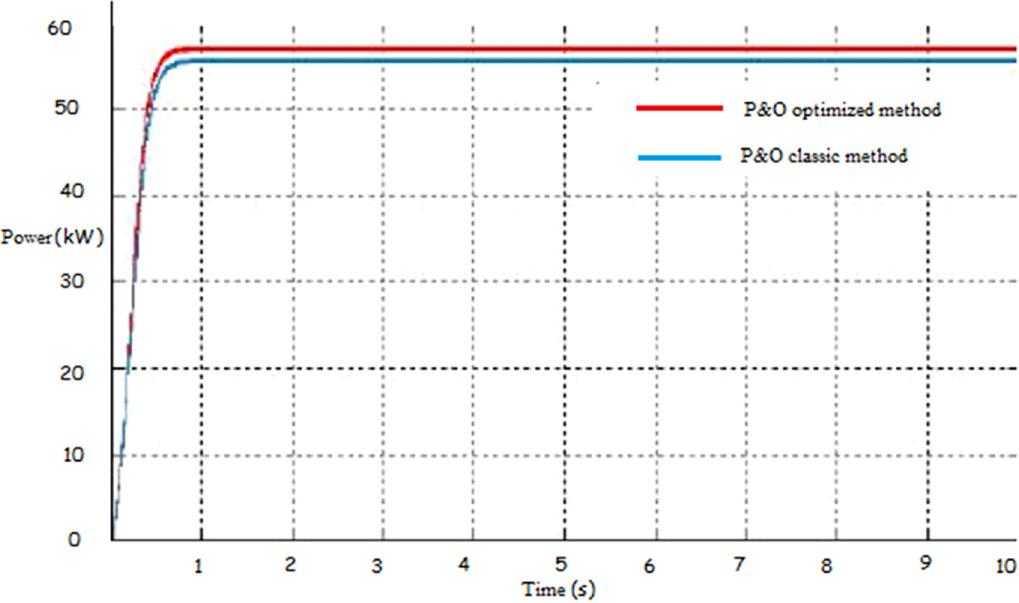
Fig. 14. Power curve for fi xed climatic